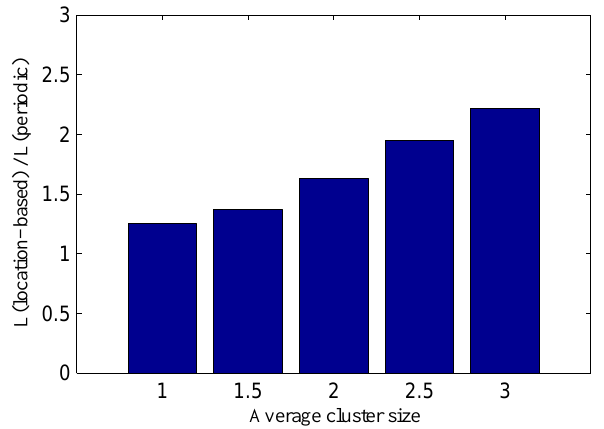
Figure 5. Network lifetime improvement vs. cluster